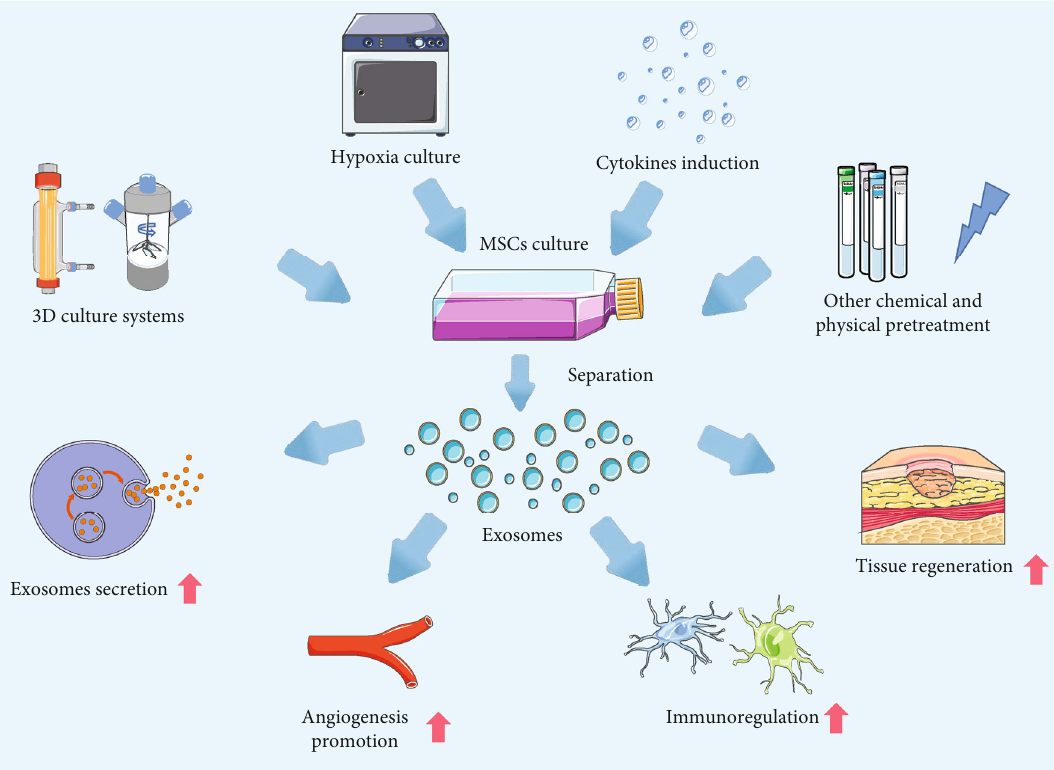
Figure 2: Current preconditioning patterns used to increase the therapeutic e ffi cacy of MSC-exosomes. A 3D culture was used to increase the secretion of MSC-exosomes and enhance their tissue damage repair e ffi cacy. A hypoxic environment may promote MSCs to secrete more exosomes; exosomes of hypoxic MSC origin perform better in proangiogenesis, immunomodulation, and tissue repair. Pretreatment with di ff erent cytokines can e ff ectively enhance the therapeutic potential of MSC-exosomes, particularly their immunomodulatory ability and tissue damage repair e ffi cacy. Other chemical and physical stimuli may alter the state and exosomal content of MSCs, thus enhancing their therapeutic potential in certain disease